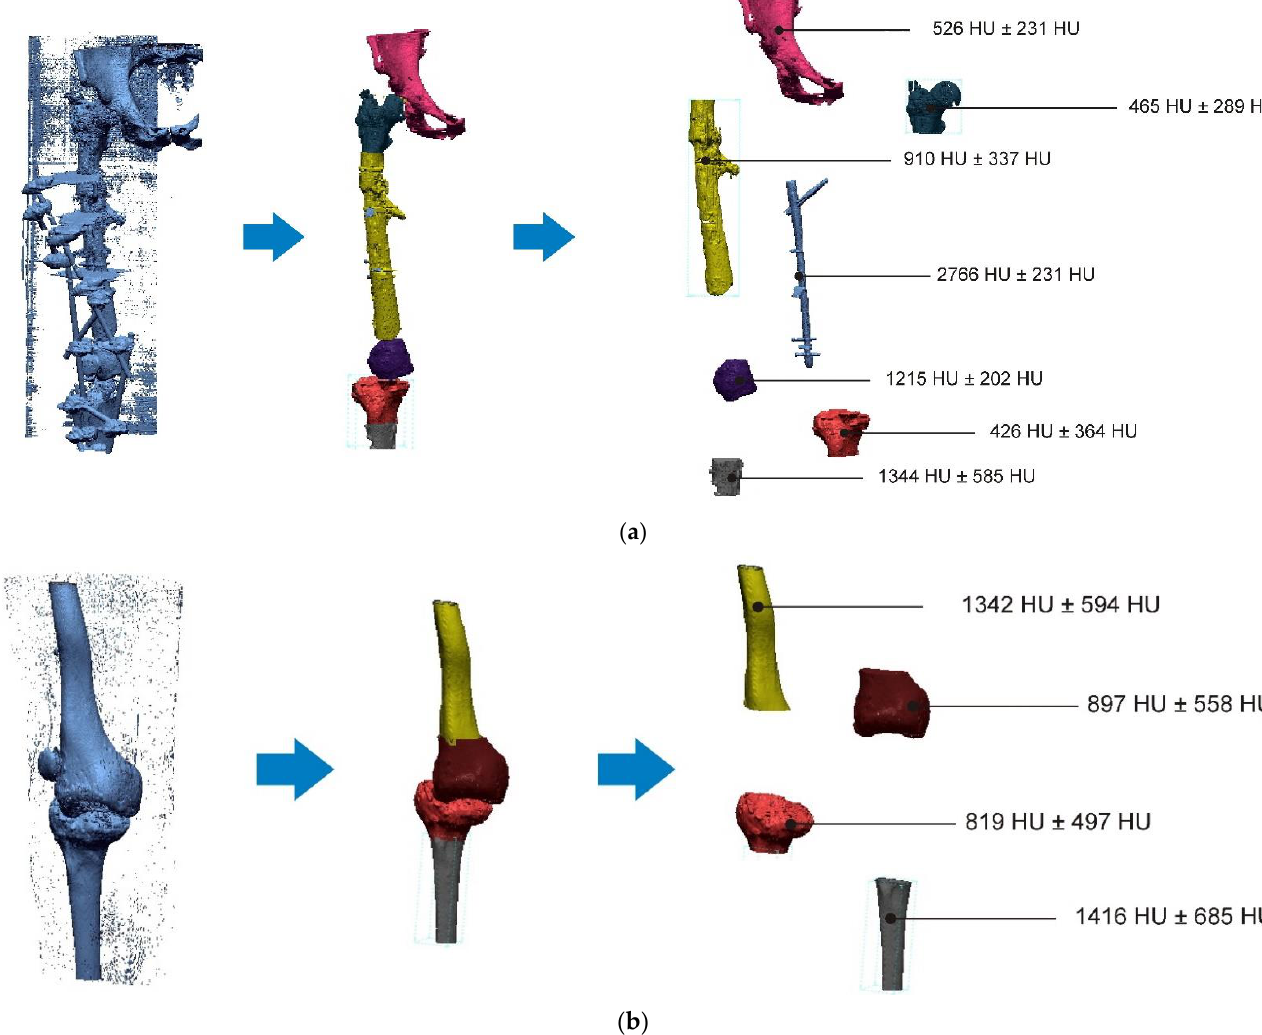
( c ) ( d ) Figure 7. Improving the segmentation process with the application of the local threshold as exemplified by: ( a ) Bone structures within the area of the hip joint and the knee joint with the implant — Patient No. 2; ( b ) Bone structures within the area of the knee joint — Patient No. 5; ( c ) Bone structures within the area of the hip joint with the implant and the bone cement — Patient No. 7; and ( d ) Bone structures within the area of the hip joint with the implant — Patient No. 10.